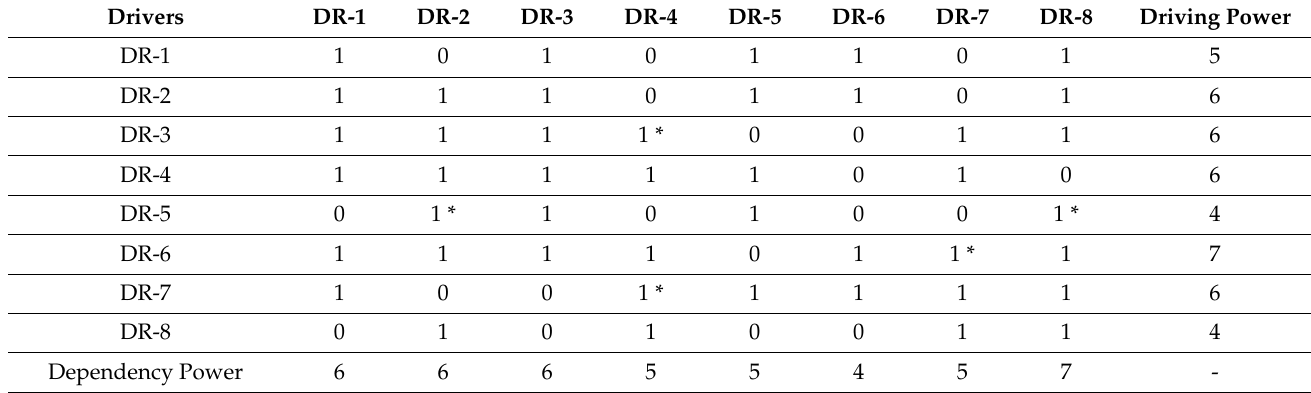
Table 2. RM for the